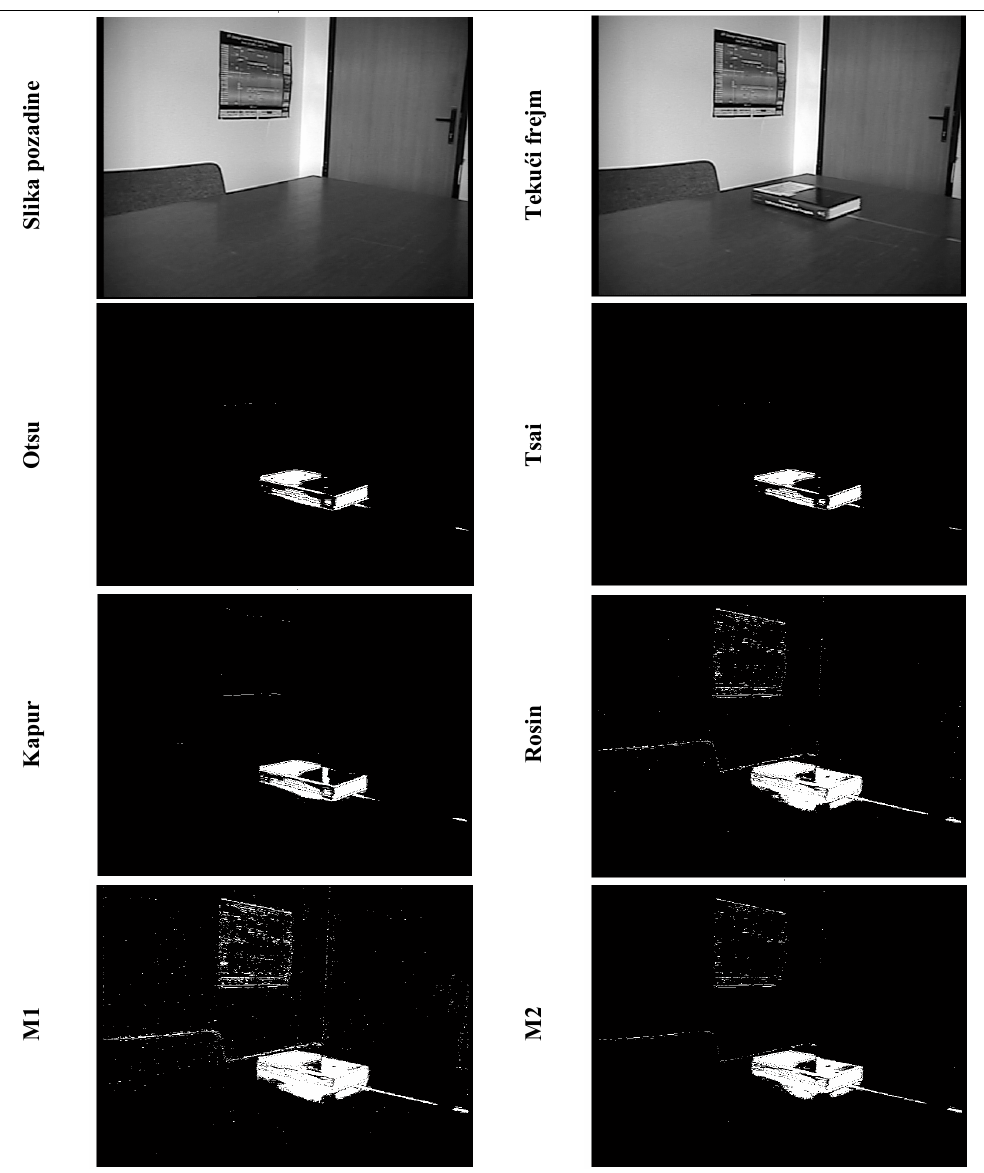
Iz tabela 2 i 3 vidi se da za sve me- (K1 odnosno K2). Ako se za ove tode odre đ ivanja praga, vrednost praga zavisi od osvetljenosti scene. Za metode koji su preuzeti iz literature (Otsu, Tsai, Kapur i Rosin) vrednosti praga zavise i od pokretnog objekta, o kojem se radi